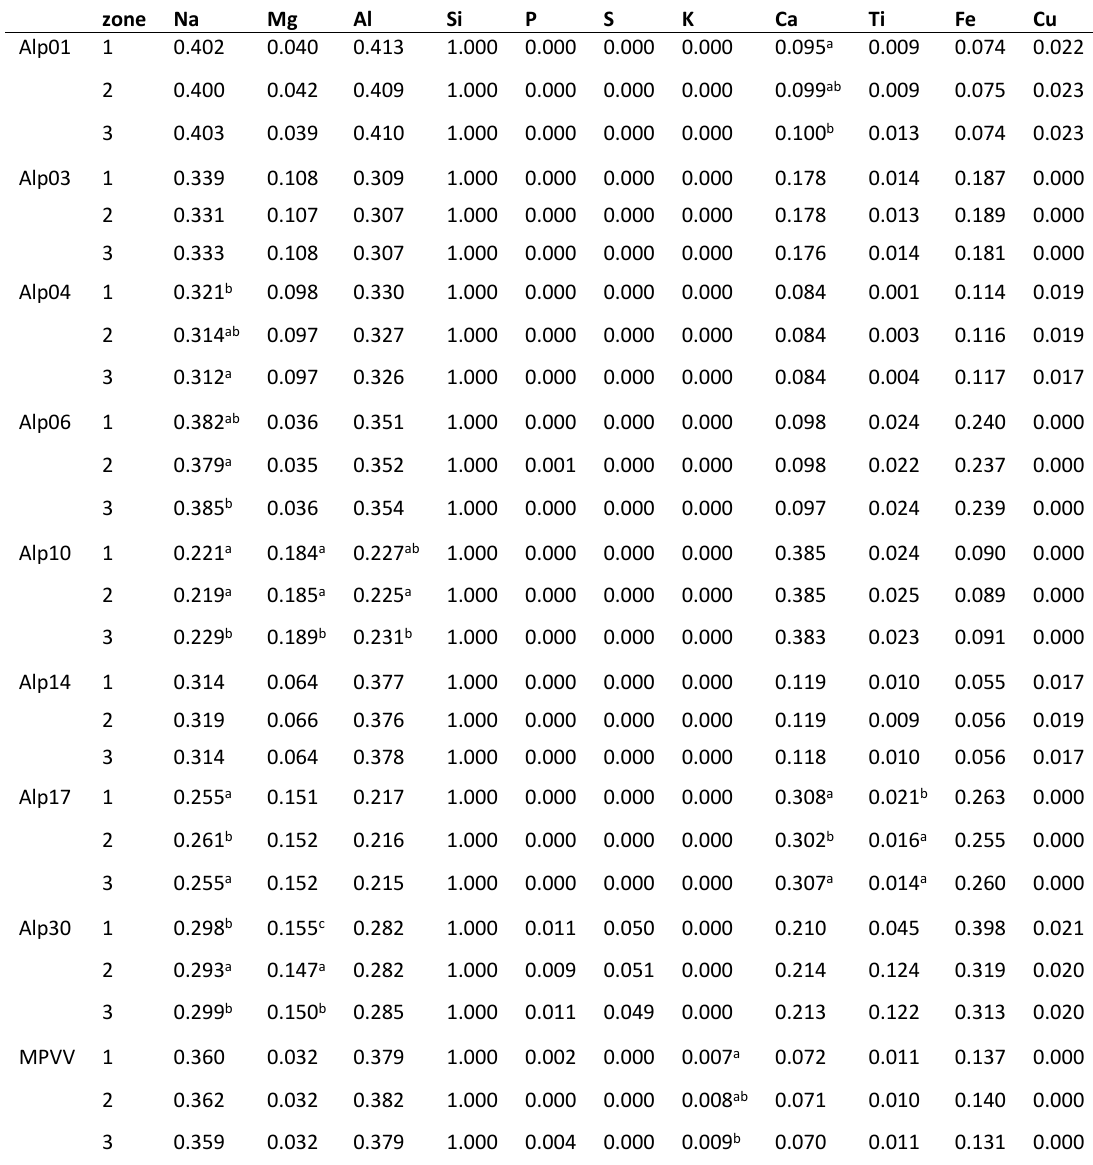
Table 3. Elemental composition. Mean value, expressed as the percentage in weight relative to Si, of the five determinations in EDX defined for each sub-sample. The absence of superscripts means that the ANOVA test did not detect significant differences between sub-samples (they belong to the same statistical group). Produced by O.